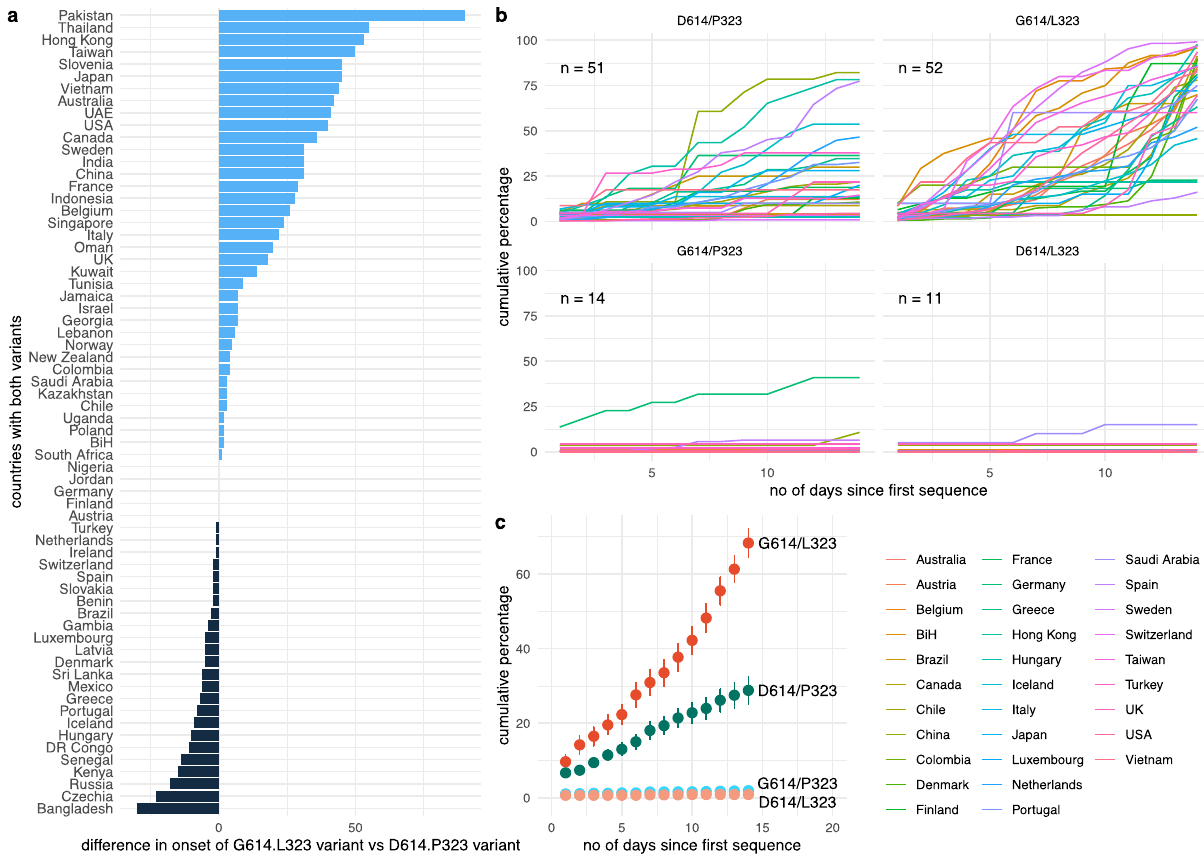
Figure 7. Comparative expansion of SARS-CoV-2 variants in different countries: ( a ) time of first reported D614/P323 sequence versus first reported G614/L323 sequence (blue bars: D614/P323 appeared before G614/ L323; black bars: D614/P323 appeared before G614/L323). ( b ) Percent of sequences of a given variant in the 14-day time period after its first appearance in a given country (100% is total number of sequences during the 14-day time period). Only countries with at least 5 sequences collected during 14 days after the appearance of first sequence are used ( c ) mean ± SEM of emergence of the variants in different countries with at least 5 sequences within the first 14